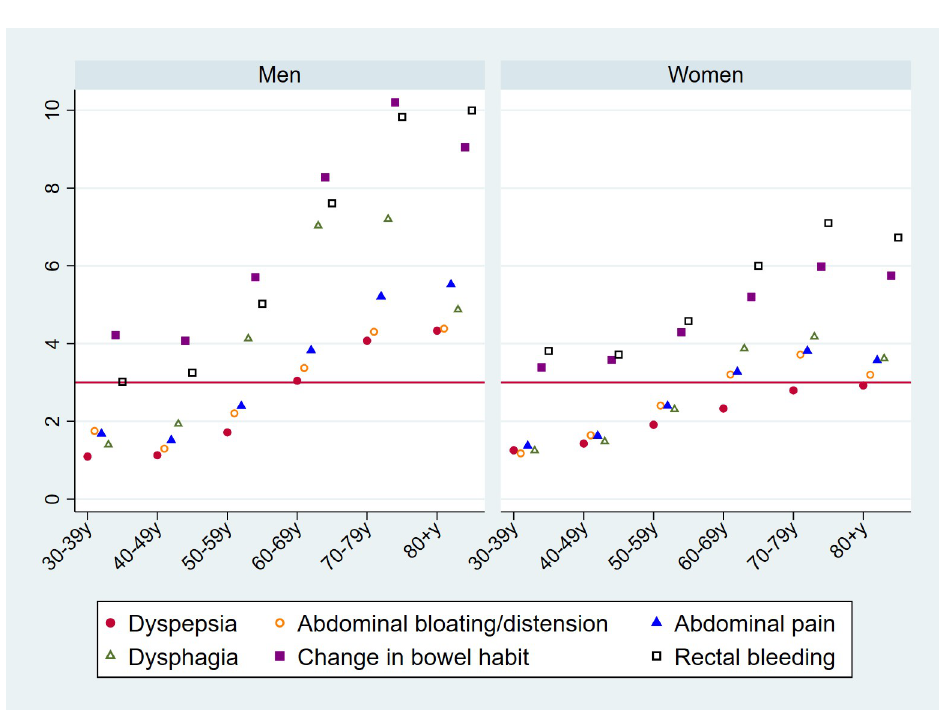
Fig 3. PPVs (%, y axis) for the composite of either cancer or IBD in the year post-presentation, per studied symptom, by sex (left/right panels) and age group ( x axis). The red horizontal line represents the NICE 3% or greater PPV threshold for urgent (two-week-wait) referral for suspected cancer. Exact values are provided in S2 Table. IBD, inflammatory bowel disease; PPV, positive predictive value. https://doi.org/10.1371/journal.pmed.1003708.g003 PLOS Medicine| https://doi.org/10.1371/journal.pmed.1003708 August 2,